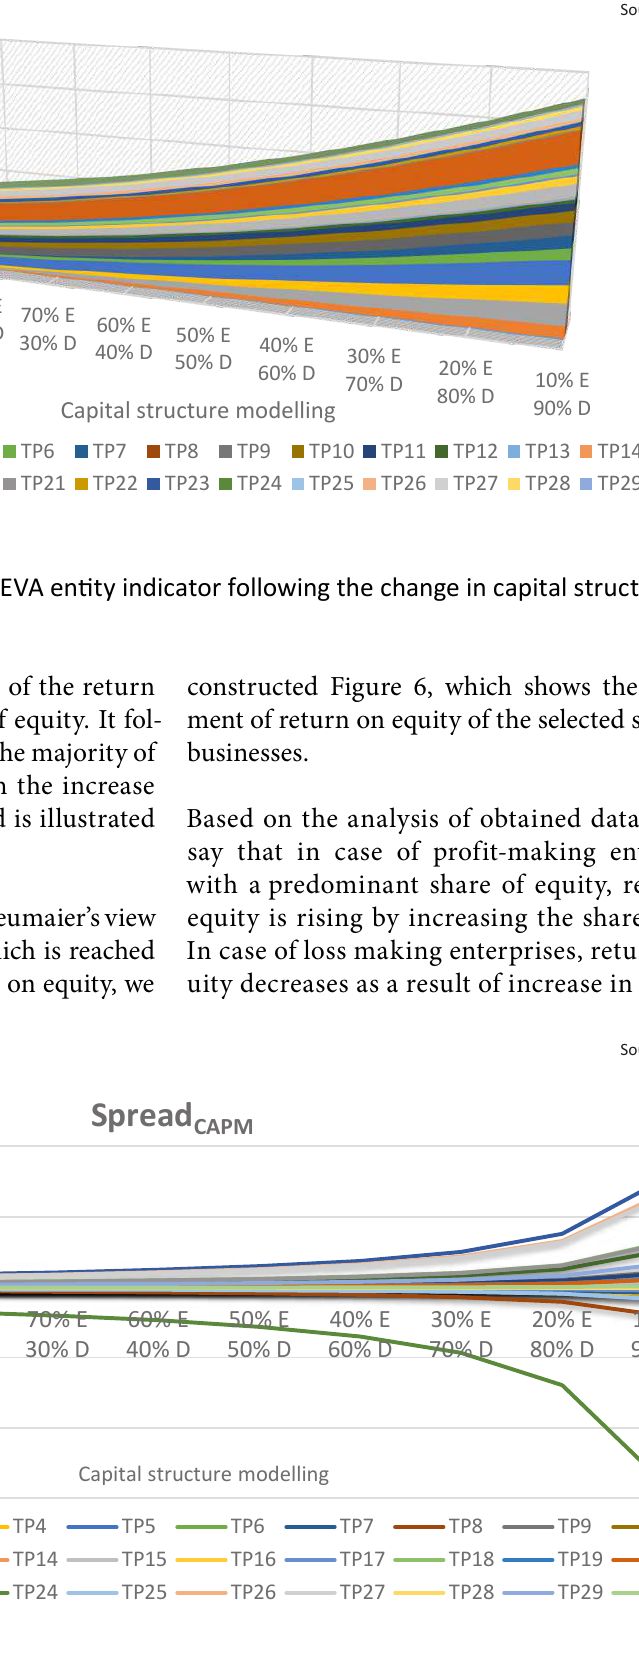
Figure 5. Development of spread following the change in capital